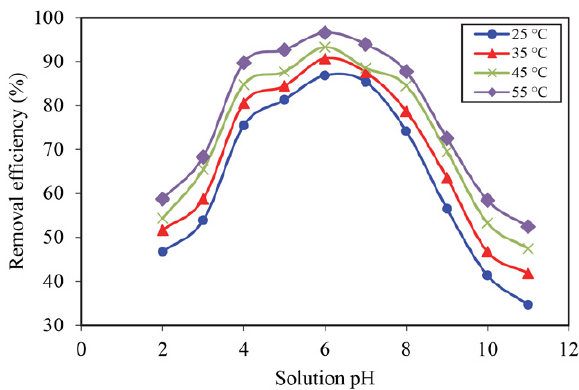
Figure 7. Impact of pH at different temperatures on the P ion sorp- tion using MnFe 2 O 4 nanoparticles (contact time = 60 min, mixing rate = 500 rpm, pH = 6, P ion concentration = 20 mg/L and adsor- bent dosage = 2 g/L)